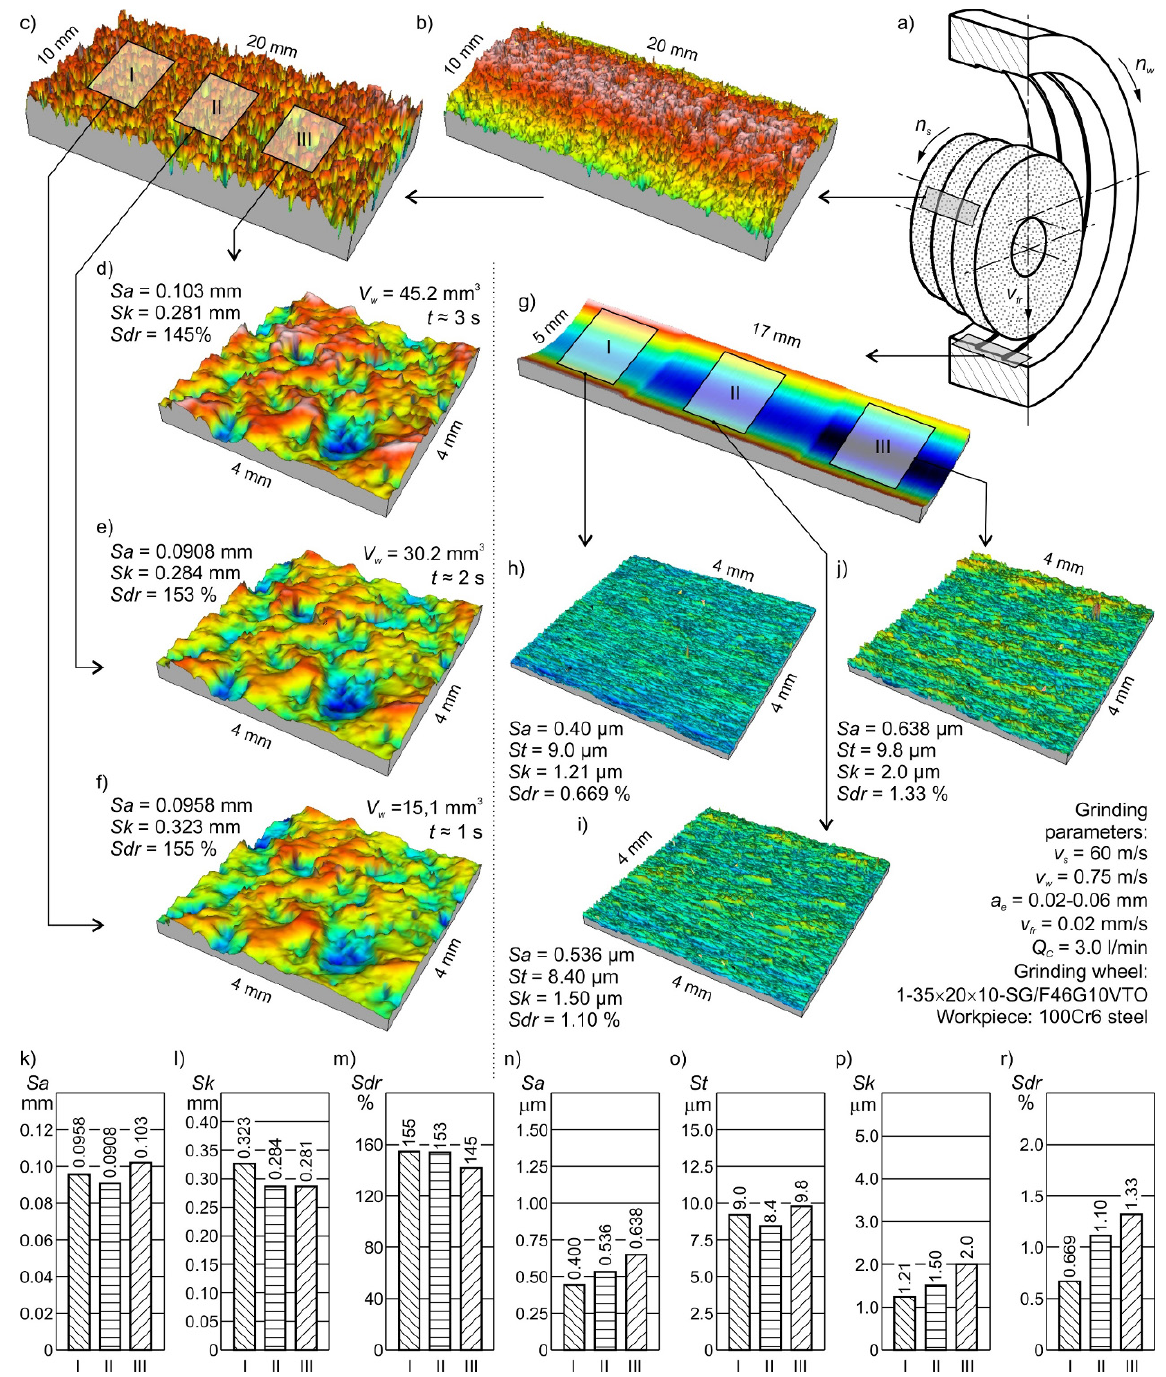
Figure 6. Microtopographies and selected GSS parameters of the active surface of the grinding wheel with zones of various diameters and the workpiece: a) scheme of the process; b) measured microtopography of the GWAS; c) levelled microtopography of the GWAS; d–f) selected GSS parameters for the three zones of the GWAS; g) measured microtopography of the workpiece surface; h–j) selected GSS parameters for the three zones of the workpiece surface; k–m) setting-up of values of the selected GSS parameters for the three areas of the GWAS; n–r) setting-up of values of the selected GSS parameters for the three areas of the workpiece